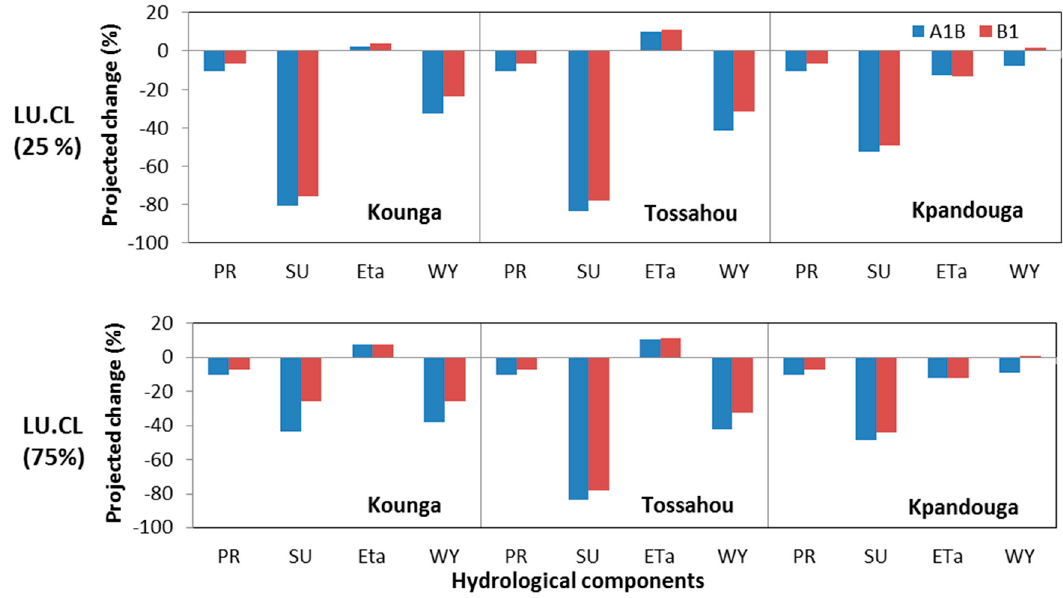
Figure 7. Changes in the annual water balance components induced by land use and climate change (LU.CL) scenarios during the projected period of 2030–2049 under traditional rice cultivation system with no fertilizers application compared to baseline condition from 1980 to 2003. A1B and B1 are climate change scenarios; ETa is actual evapotranspiration; PR is precipitation; SU is surface runoff; and WY is total water yield.